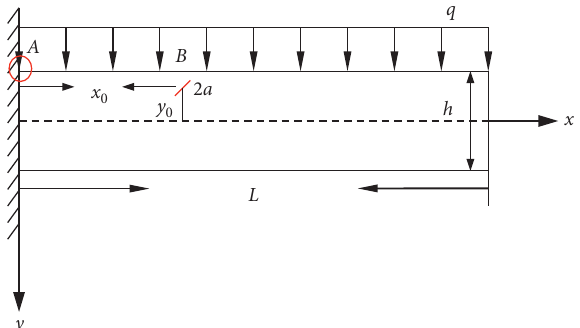
Figure 3: Stress analysis diagram of roof with internal crack.